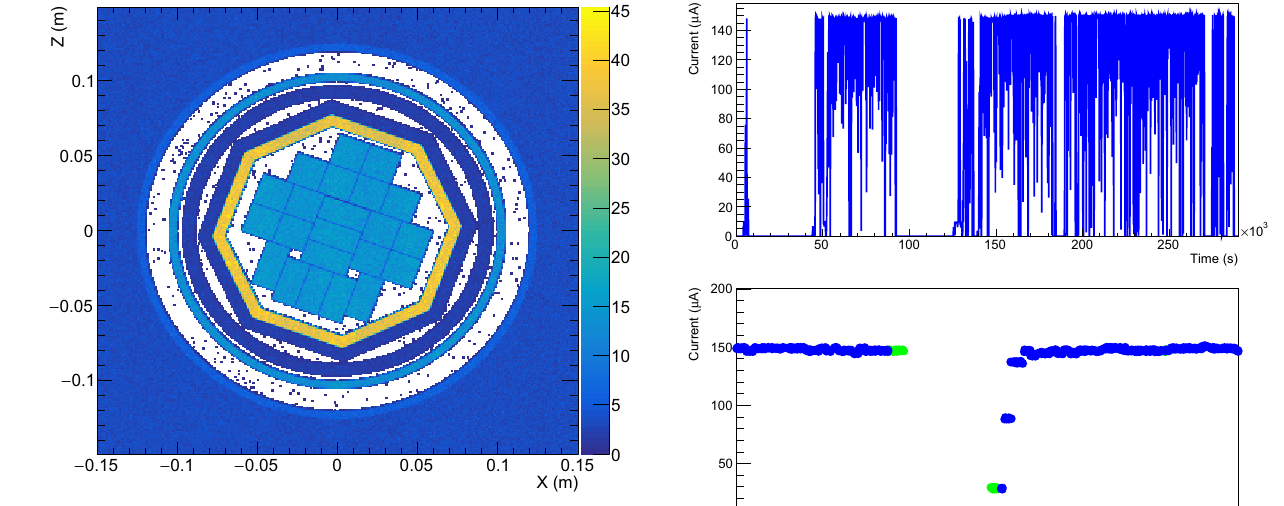
Fig. 10 Distributionofneutrinointeractionvertices(inarbitraryunits) intheBDX-MINIdetectorasobtainedfromtheGENIEsimulation.The color scale reflects the interaction probability and therefore the density of detector materials. Cyan: PbWO 4 crystals, yellow: tungsten shield- ing, dark blue: IV and OV: OV, light blue: stainless steel vessel, white: air between vessel and PCV pipe, blue: PCV pipe and surrounding dirt